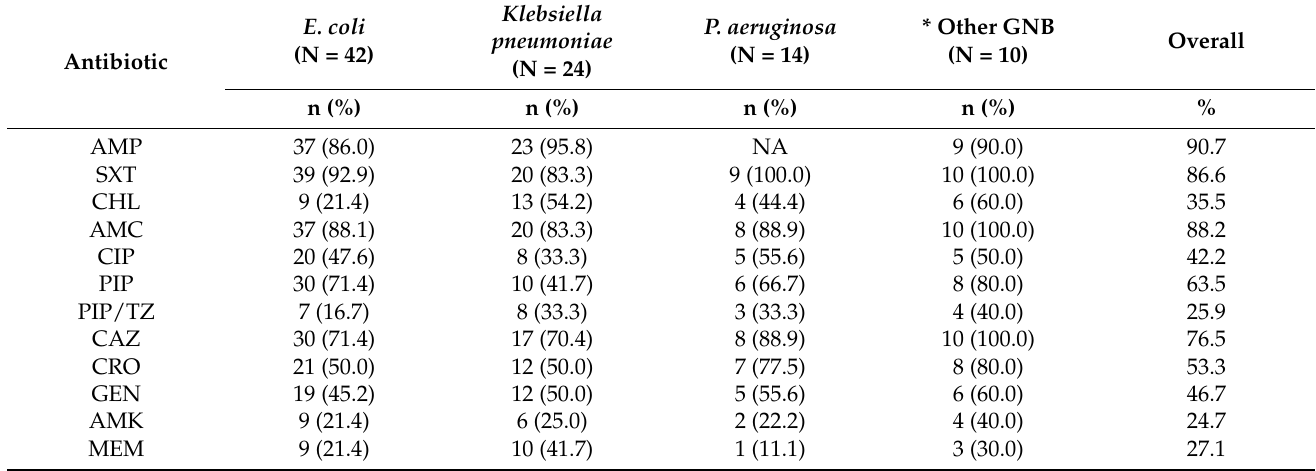
Table 4. Proportion of antibiotic resistance in Gram-negative pathogens causing neonatal sepsis.